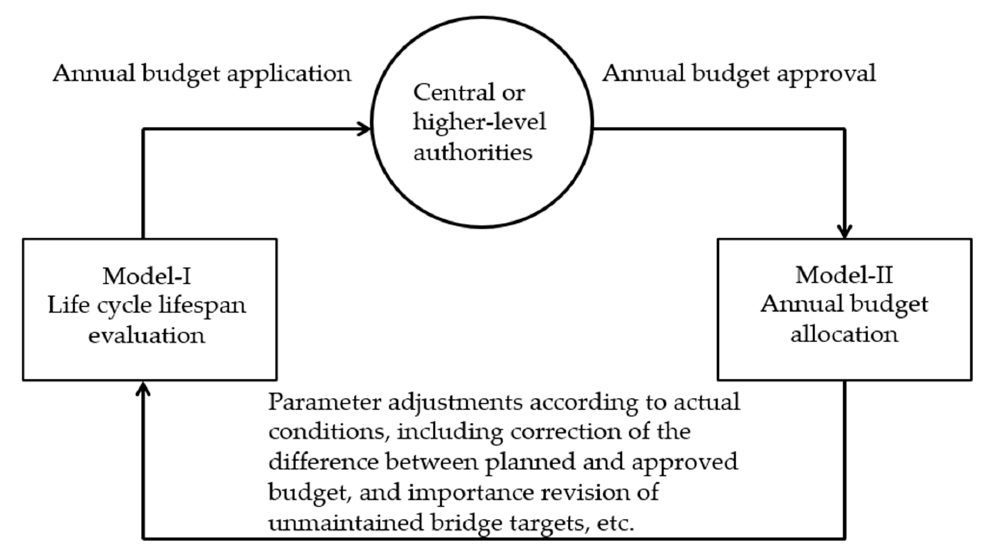
Figure 5. Annual recursive implementation process of two models.